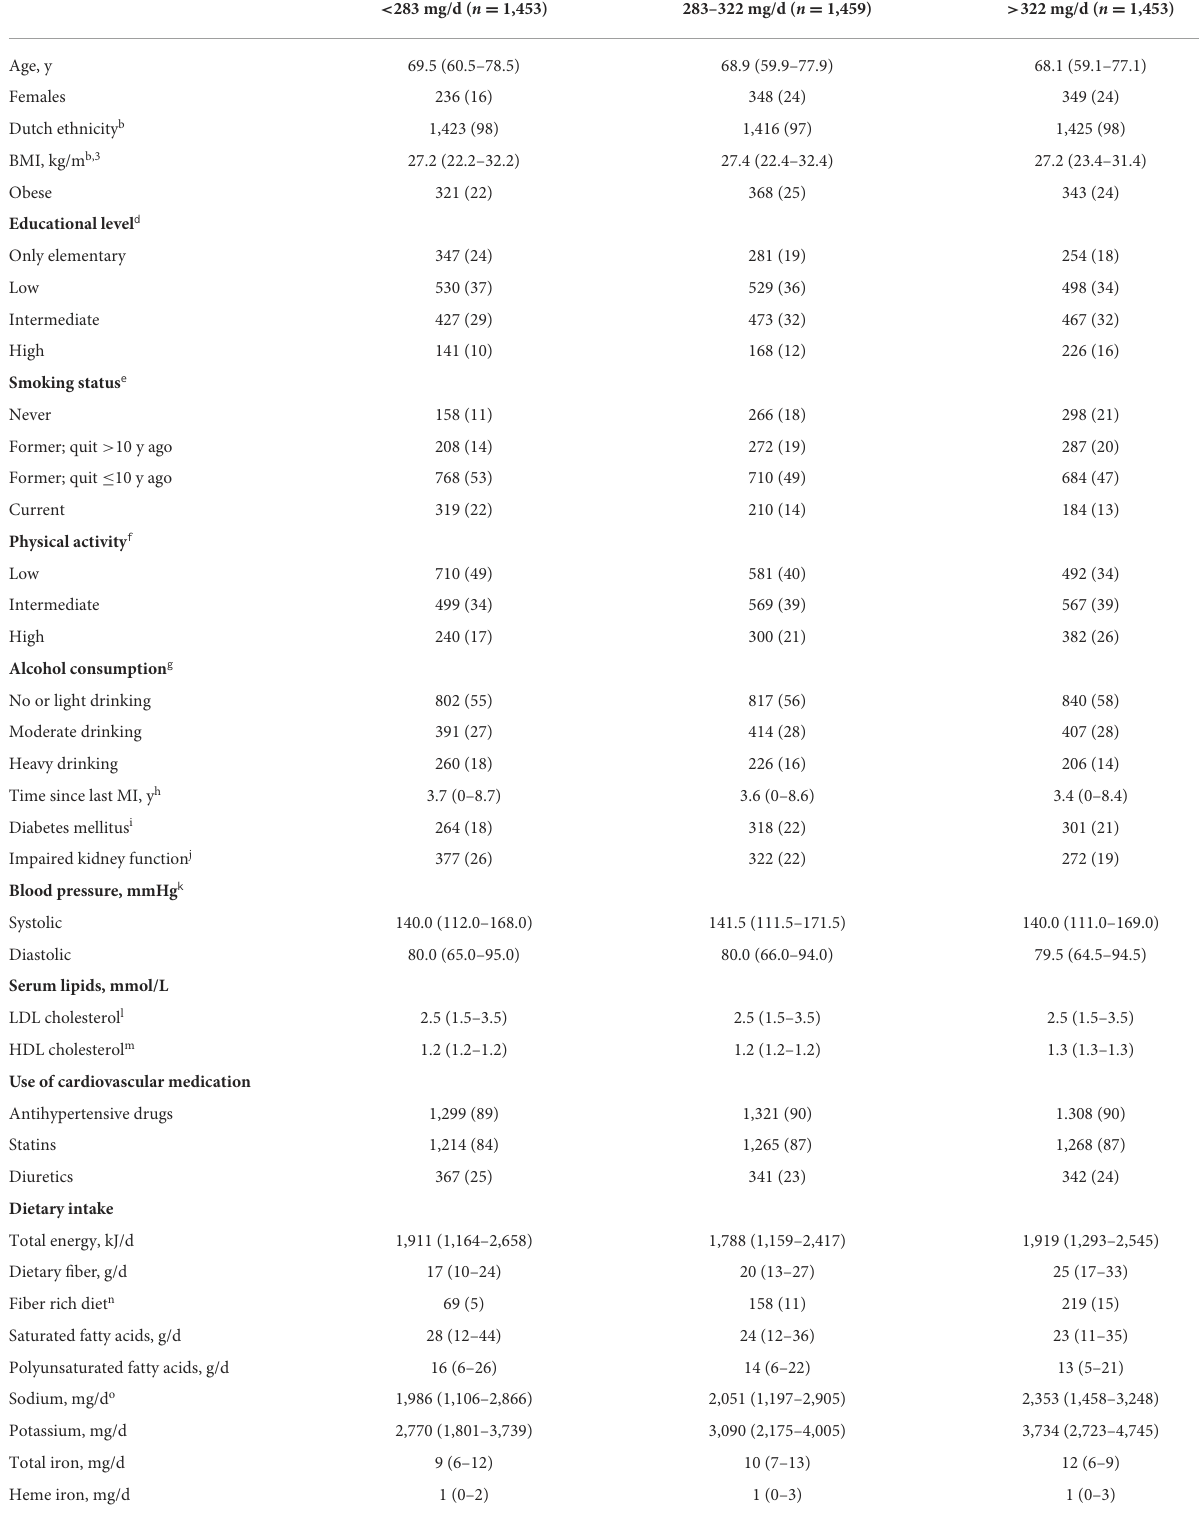
TABLE 1 Baseline characteristics of 4,365 post-MI patients from the Alpha Omega Cohort, by tertiles of energy adjusted magnesium intake a